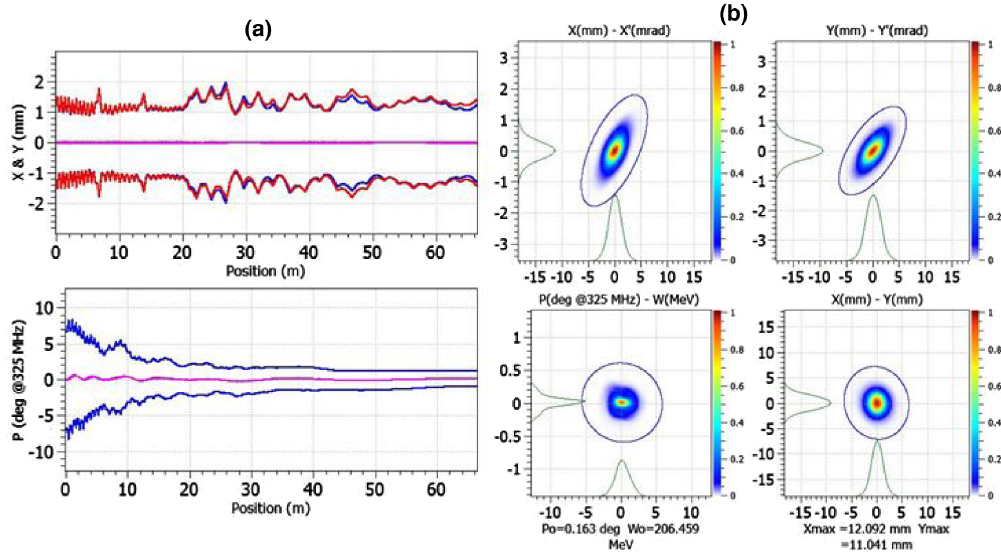
FIG. 37. (a) Evolution of transverse and longitudinal RMS beam size, and (b) Phase-space and coordinate-space particle density distribution at the exit of the SC section of the MEHIPA